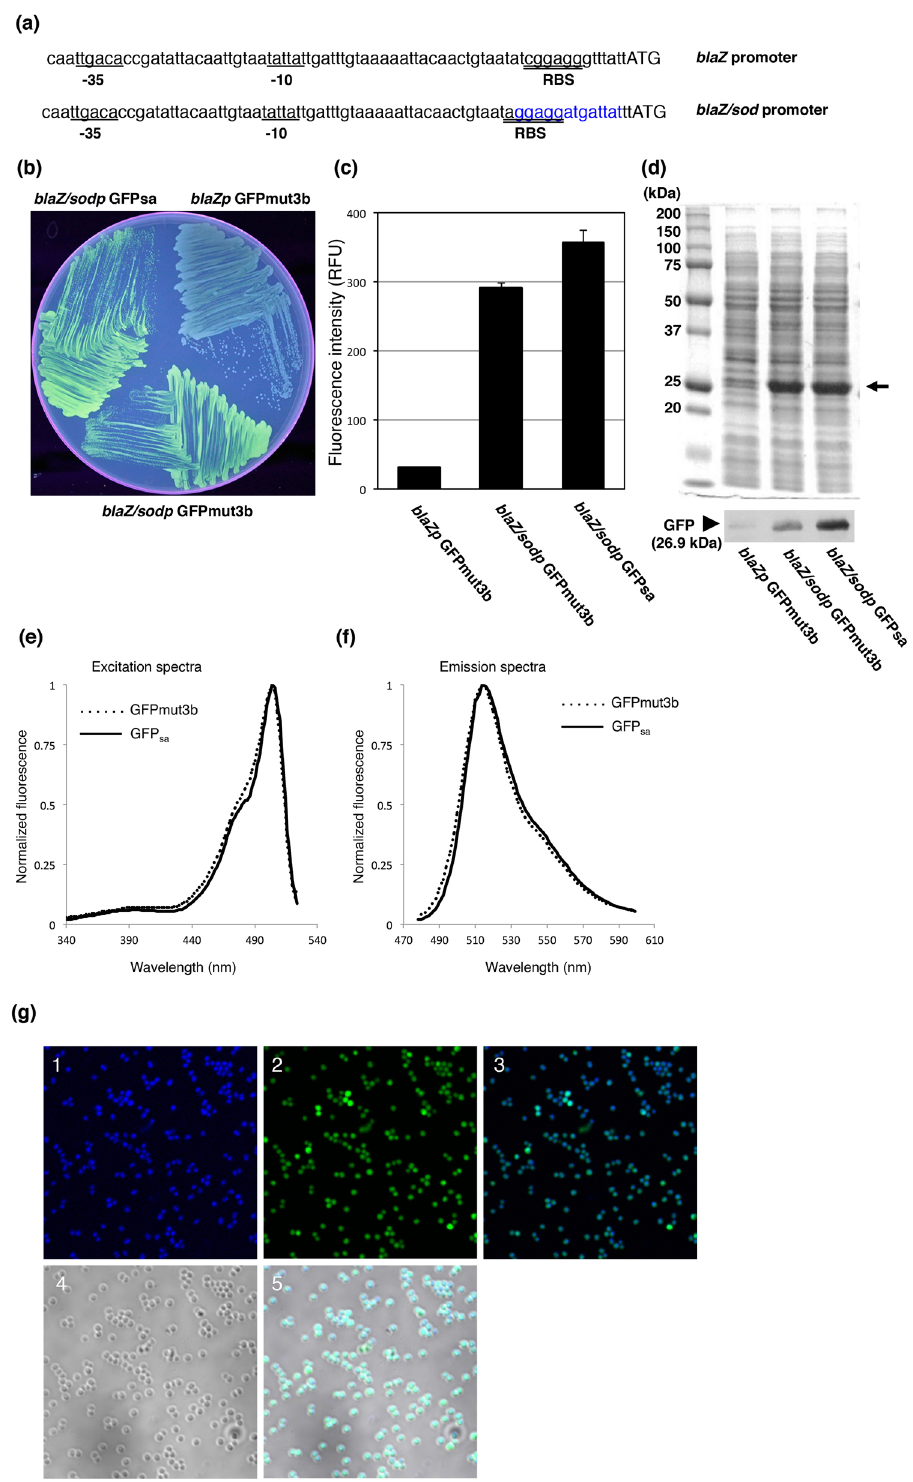
Figure 1. Replacement of RBS sequence and introduction of Cycle3 mutations into GFPmut3. ( a ) Sequence alignment of the blaZp and its derivative blaZ / sodp promoters. Blue bold face indicates the surrounding sequence containing RBS derived from the sod gene. Underlined sequences indicate − 35 and − 10 elements of the blaZ promoter. Double underlines indicate the RBS sequence. Initiation codons are shown in uppercase. ( b ) The fluorescing colonies were photographed under UV excitation. S . aureus RN4220 containing pS1GFP, pFK51, and pFK52 were grown on TSB agar plate containing chloramphenicol. ( c ) The fluorescent intensities of GFPmut3b, and GFP sa in S . aureus RN4220. Cell homogenate of S . aureus containing pS1GFP, pFKS1 and pFK52 was prepared and the fluorescent intensities at 513 nm were measured with a microplate reader, λ = 490 nm. The data represent mean values ± standard deviation. ( d ) The expression efficiency of ex